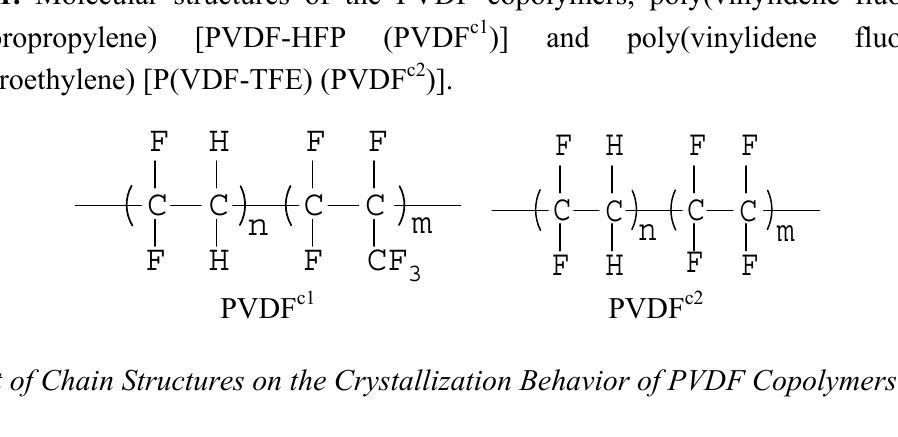
Figure 1. Molecular structures of the PVDF copolymers, poly(vinylidene fluoride- co - hexafluoropropylene) [PVDF-HFP (PVDF c1 )] and poly(vinylidene fluoride- co - tetrafluoroethylene) [P(VDF-TFE) (PVDF c2 )].